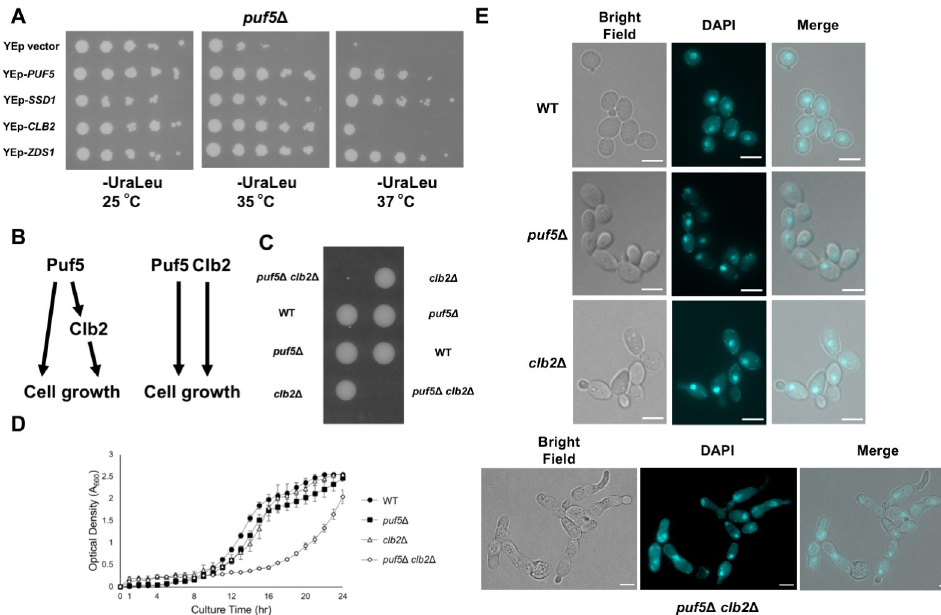
Fig 1. Overexpression of CLB2 repressed the temperature-sensitive phenotype of the puf5 Δ mutant. (A) The multi- copy suppressors of the temperature-sensitive phenotype of the puf5 Δ mutant. The puf5 Δ mutants harboring YEp13, YEp13- PUF5 , YEp13- SSD1 , YEp13- CLB2 , or YEp13- ZDS1 in addition to the plasmids pRS316-3xFLAG- LRG1 were cultured at 25˚C, serially diluted, and spotted onto an SC-Ura-Leu plate, and incubated for 4 days at 25˚C, 35˚C, or 37˚C. (B) Models showing how Puf5 and Clb2 function in cell growth. One is that Clb2 is a downstream target of Puf5, and the other is that Puf5 and Clb2 function in a parallel manner. (C) The tetrad analysis of the strains that are heterozygous for the alleles of PUF5 and CLB2 . The cells were sporulated, dissected on a YPD plate, and cultured at 30˚C for 3 days. (D) The growth curve of wild-type (black circle), the puf5 Δ mutant (black square), the clb2 Δ mutant (white triangle), and the puf5 Δ clb2 Δ mutant (white rhombus) at 25˚C. The strains were pre-cultured in a YPD medium containing 10% sorbitol overnight at 25˚C, and then transferred into a fresh YPD-Sorbitol medium and cultured at 25˚C for 1 day. The data shows the mean ± SE (n = 3) of the optical density. (E) Morphology of wild-type, the puf5 Δ mutant, the clb2 Δ mutant, and the puf5 Δ clb2 Δ double mutant cells. Bright-field (left), DAPI staining (middle), and the overlayed (right) were shown. The scale bar represents 5 μ